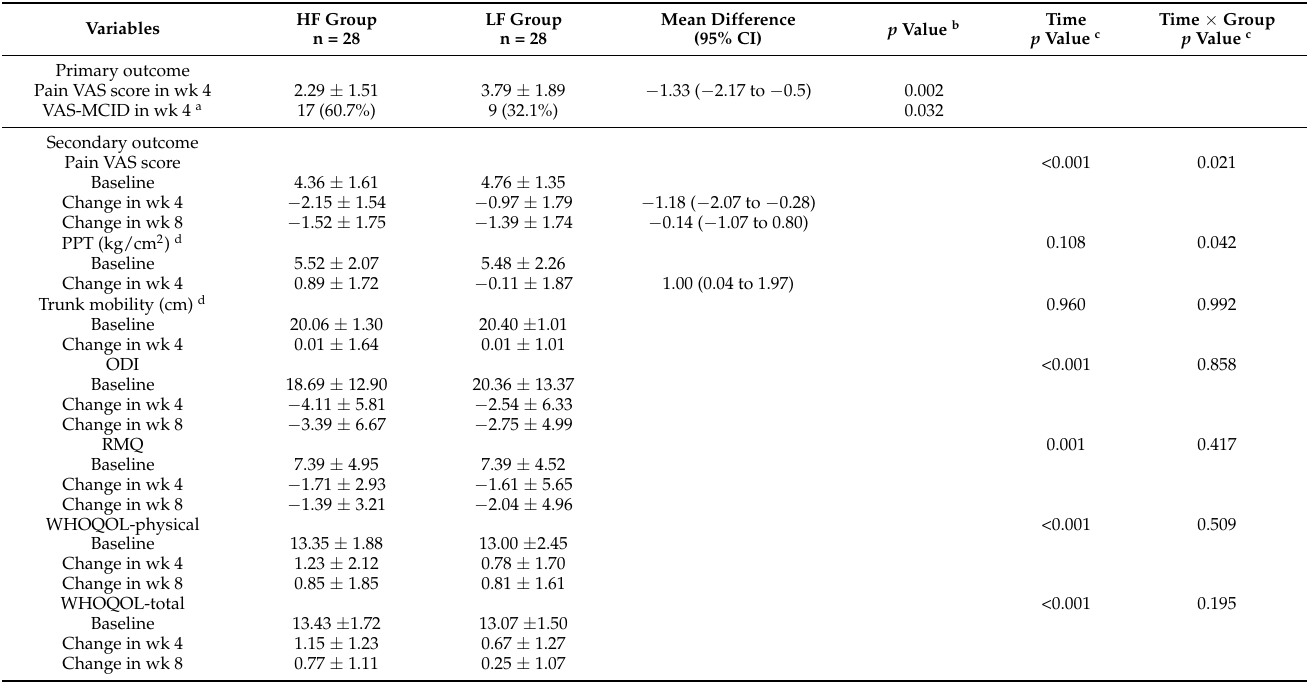
Table 2. Effects of Massage Force on the Study Outcomes.